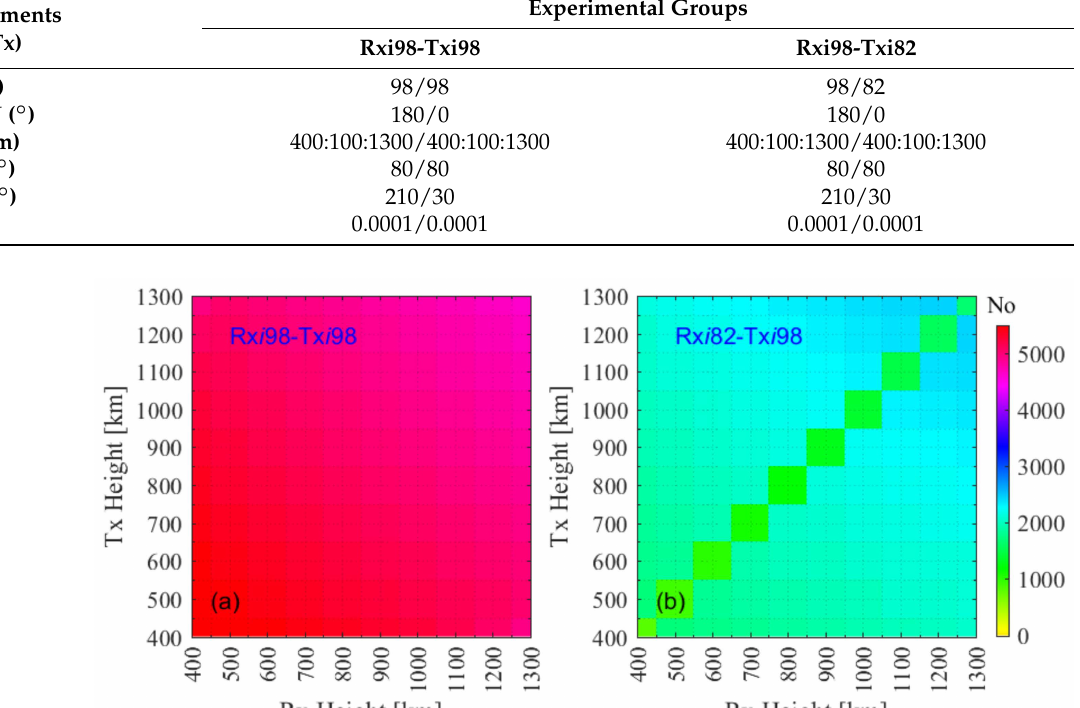
increase. The occultation number and the global coverage fraction of the Rxh1300-Txh1200 constellation reach a maximum of approximately 2400 and 61%, respectively. However, compared with the Rxi90-Txi90 and Rxi98-Txi98 constellations, the occultation number and the global coverage fraction of Rxi98-Txi82 are both